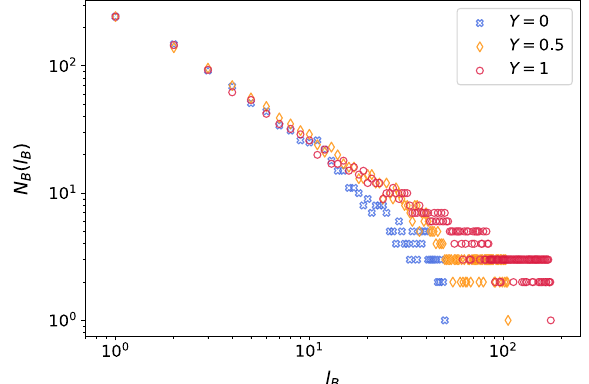
Fig. 9 Illustration of the fractality of the Repulsion based fractal model for different parameter settings. The iteration number is chosen to be five, and m =